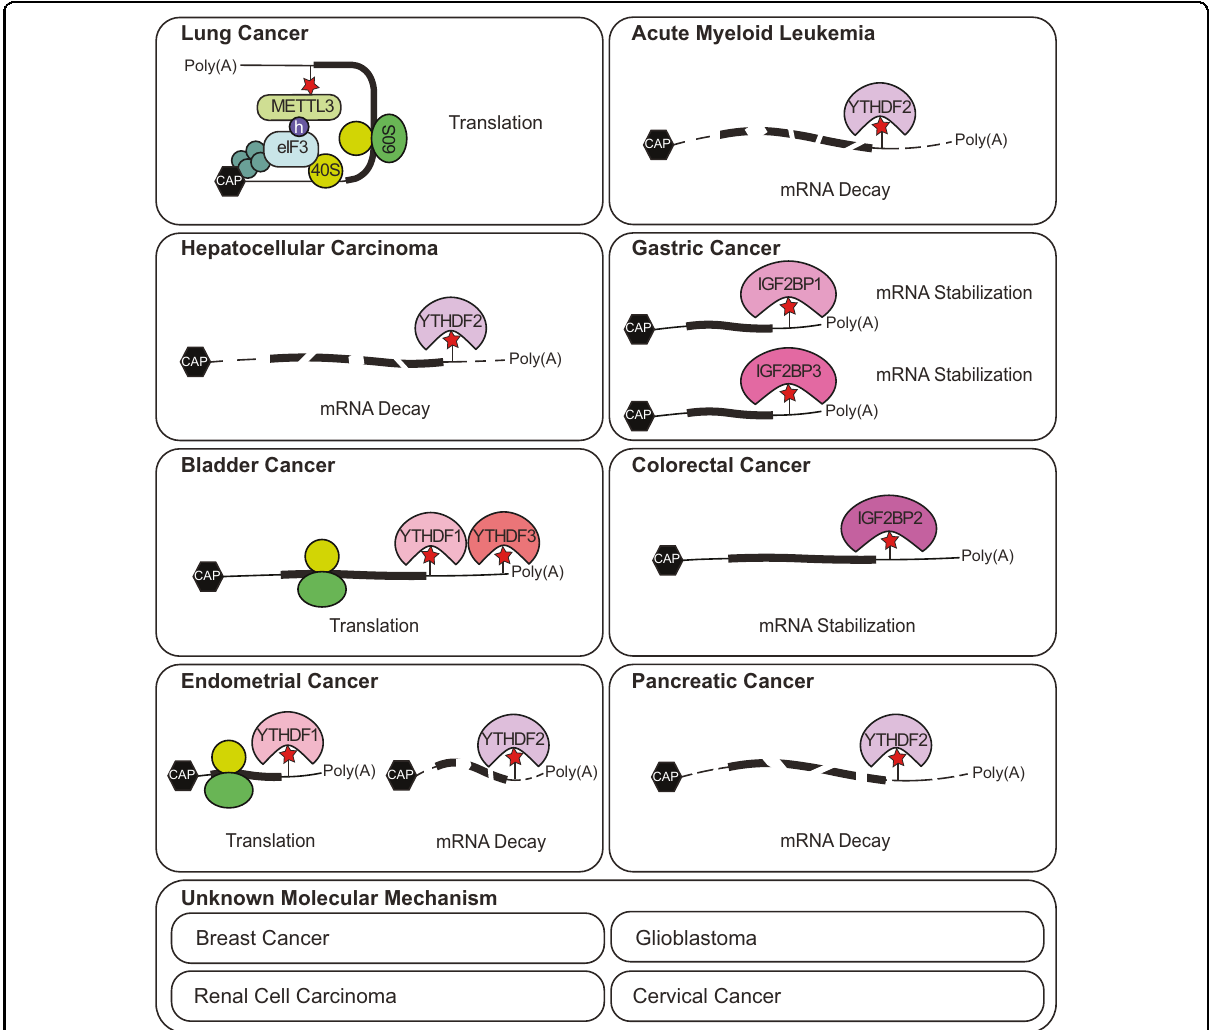
Fig. 3 m 6 A-mediated mRNA regulation in tumorigenesis. A number of studies have identi fi ed the molecular mechanism of m 6 A-mediated mRNA regulation and their effects on tumorigenesis. To date, m 6 A-mediated regulation of translation or mRNA stability has been demonstrated, while the relevance of pre-mRNA splicing or mRNA export remains unclear for speci fi c cancer